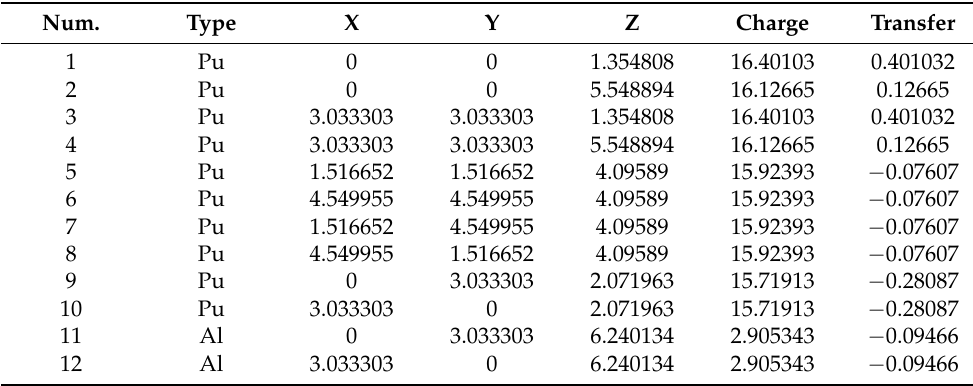
Table 3. Surface atom charge transfer in Pu-Al system without H absorbed. Num.